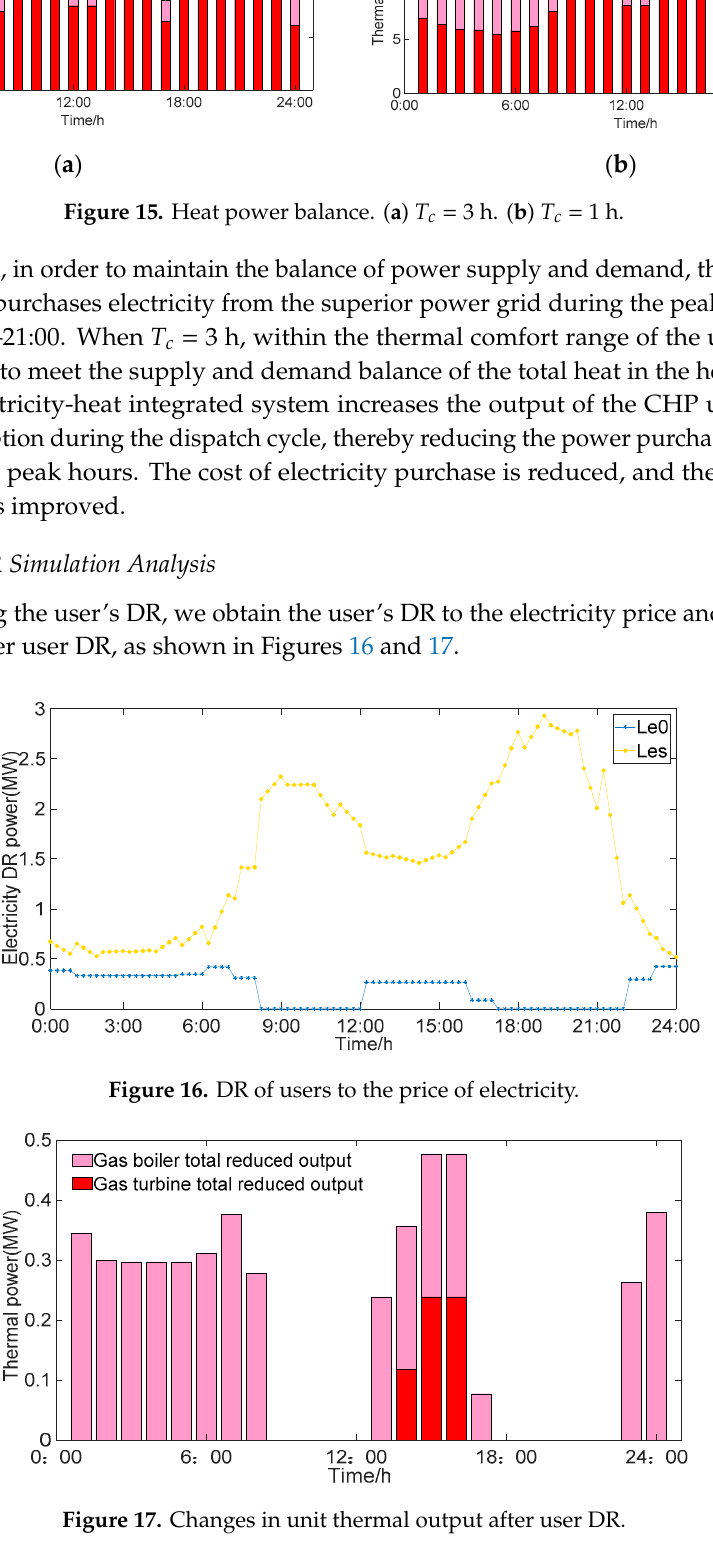
Figure 15. Heat power balance. ( a ) c